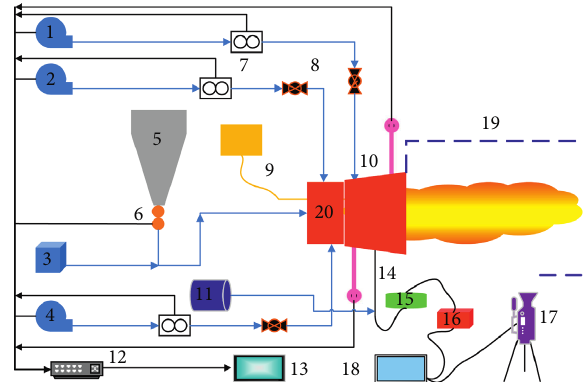
Figure 1: Schematic diagram of the experiment system.1, 2, and 4- blower; 3- Roots fan; 5- storage facilities; 6- feeding device; 7- mass flowmeter; 8- valve; 9- ignition device; 10- thermocouple; 11- air compressor; 12- signal exchanger; 13- desktop computer; 14- sampling device; 15- filter unit; 16- flue gas analyzer 17- high-speed camera; 18- notebook computer; 19- protective wall; and 20-